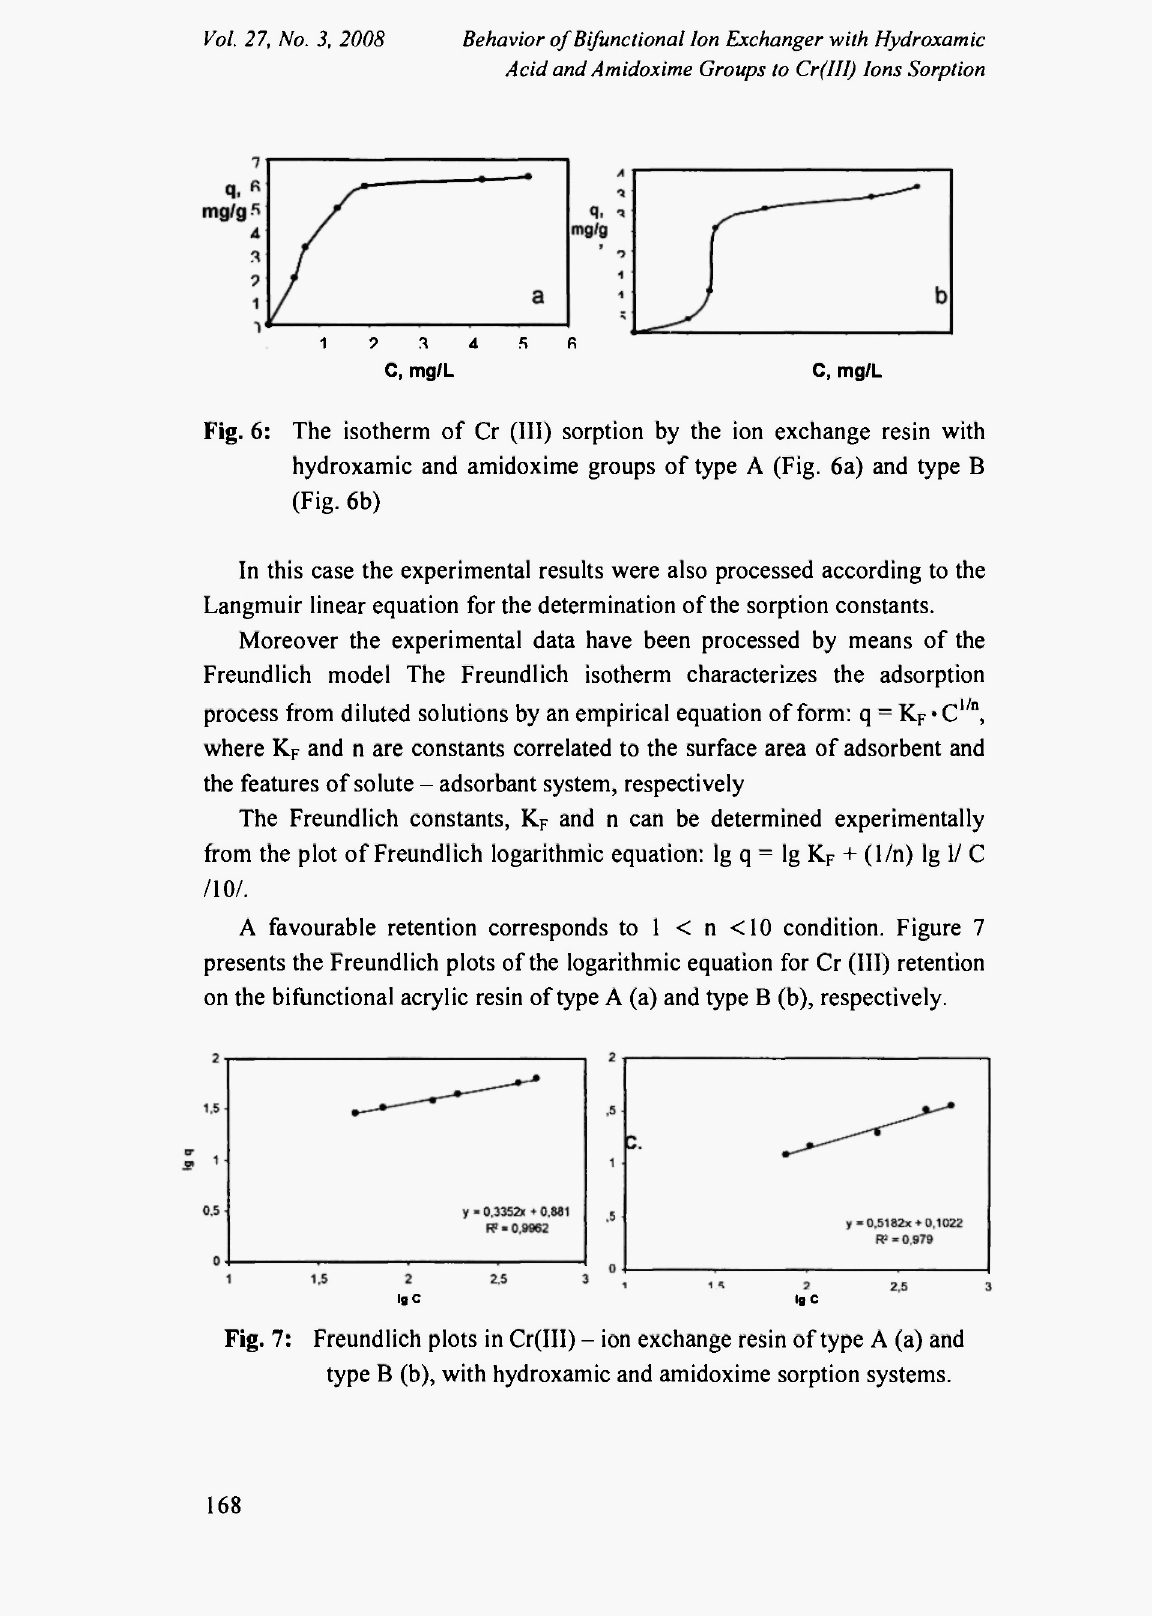
Fig. 7: Freundlich plots in Cr(III) - ion exchange resin of type A (a) and type Β (b), with hydroxamic and amidoxime sorption